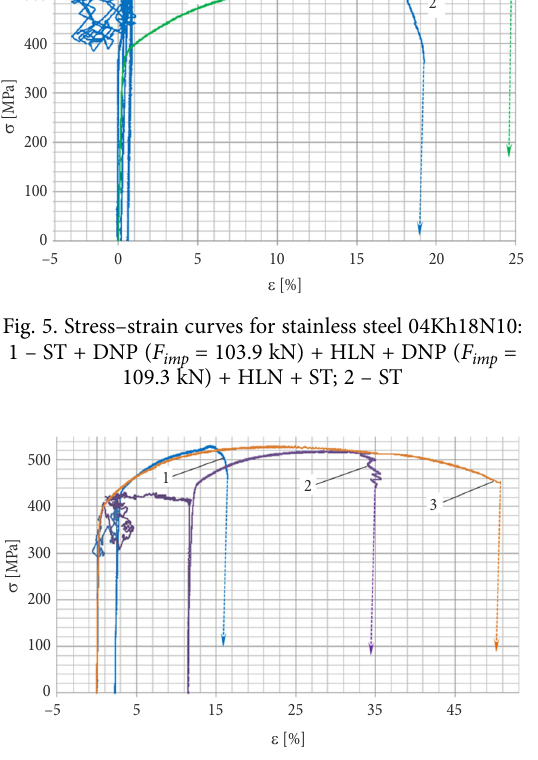
Fig. 6. Stress–strain curve for stainless steel 04Kh18N10: 1 –